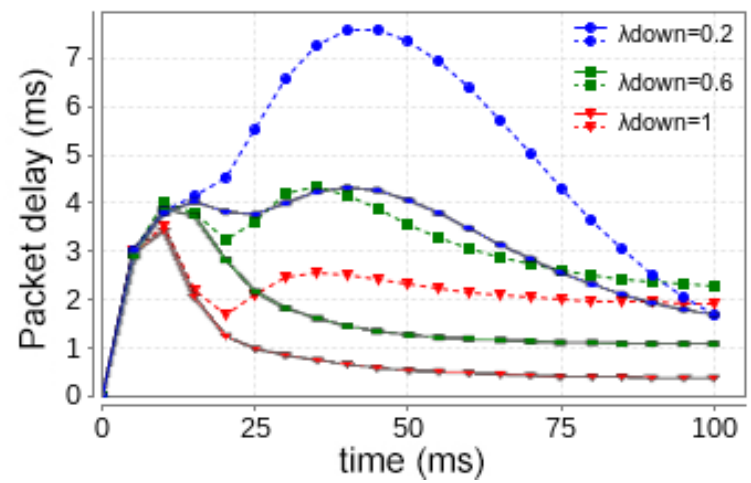
Figure 8. Downstream packet delay: mechanism proposed in [21] (dotted line) wake-up and time-out mechanisms (solid line).